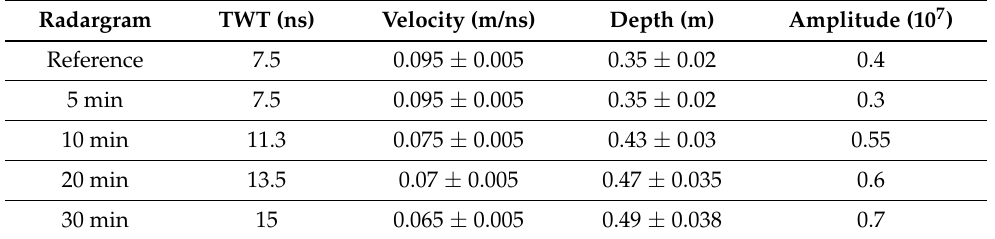
Table 1. Characteristic values for hyperbolas (B’) and (B) observed in radargrams of Figure 10. Radargram TWT